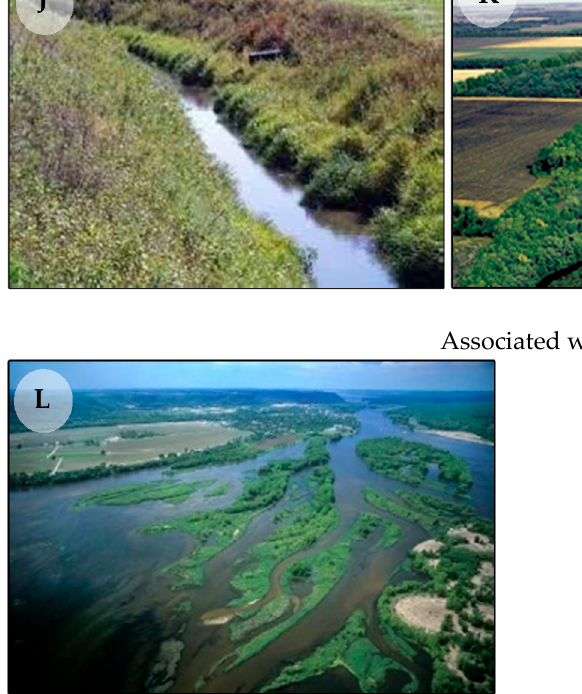
Figure 2. Examples of natural infrastructure in agricultural landscapes. ( A ) Wetlands—depressional (photo credit: USGS, David Mushet), ( B ) Conversion of crop land to native vegetation—forest (photo credit: USFS), ( C ) Conversion of crop land to native vegetation—grasses (photo credit: USDOE, ( D ) Runoff attenuation features (photo credit: Nick Barbers, Newcastle University), ( E ) Farm ponds (photo credit: USDA-NRCS), ( F ) Wetlands—engineered (photo credit: Matthew Helmers, Iowa State University), ( G ) Saturated buffers – conventional on left and saturated buffer on right (photo credit: USDA), ( H ) Vegetated ditches (photo credit: USDA-ARS), ( I ). Stream restoration before and after (photo credit: EPA), ( J ) Two-stage ditches (photo credit: USDA-NRCS), ( K ) Riparian forest buffer (photo credit: USFS), ( L ) Floodplain restoration (photo credit: USGS).